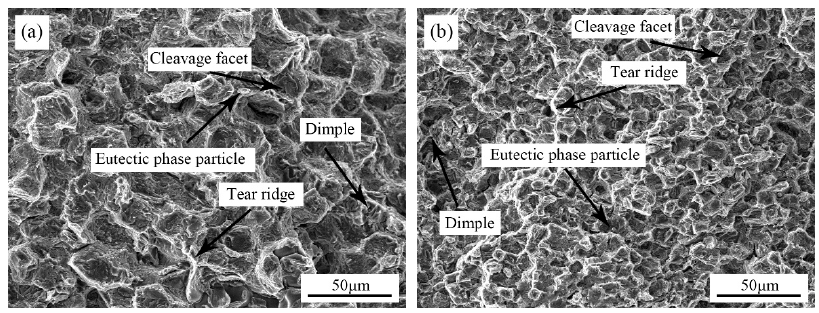
Figure 11. Fractures of the as-cast Mg-3Y-3.5Sm-2Zn-0.6Zr alloy: ( a ) Without UST; ( b ) with UST.